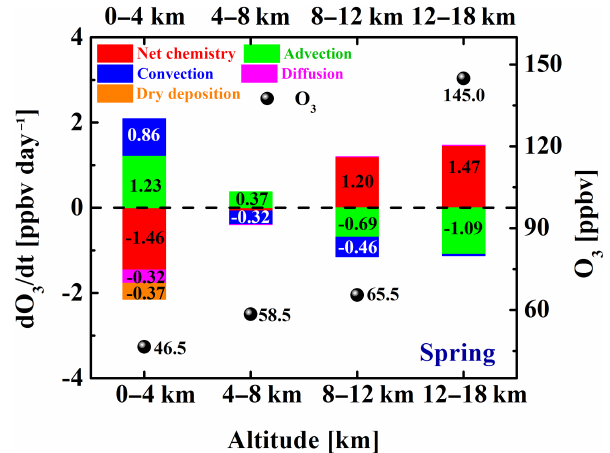
Figure 10. Averaged ozone budget in pre-monsoon from MOZART-4 at four layers over AS region. The ozone partial col- umn volumes (ppbv) calculated from MOZART-4 is presented as black